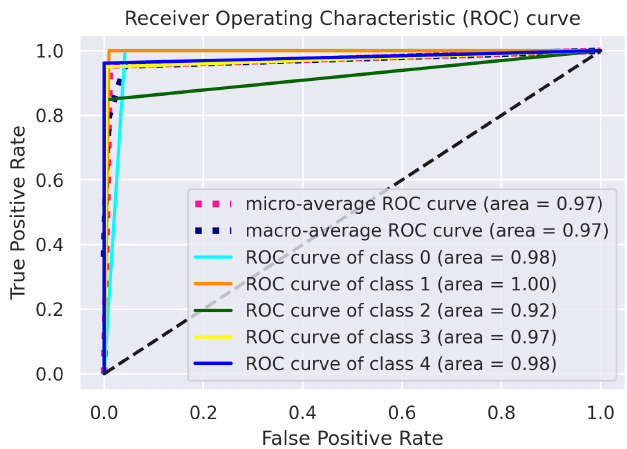
Figure 7. ROC graph of the ensemble